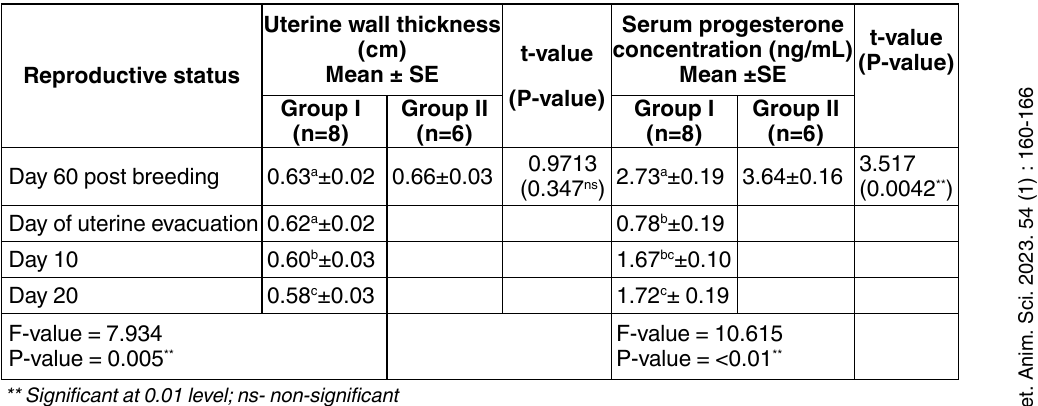
table 1. Uterine wall thickness and serum progesterone concentration (ng/mL) in pseudopregnant and pregnant